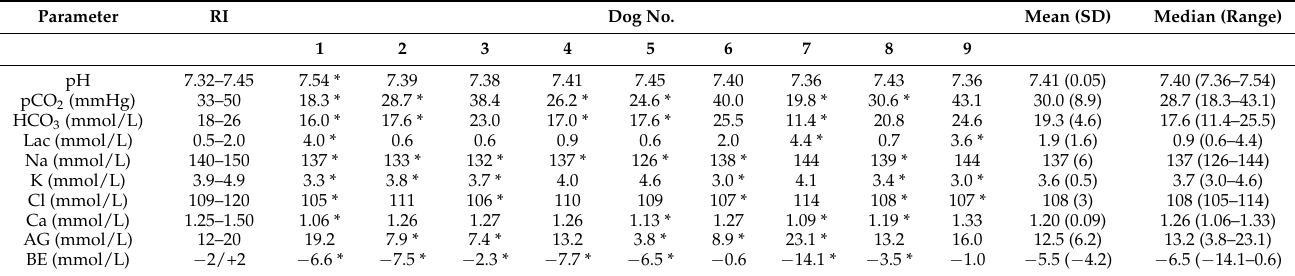
Table 3. Blood gas analyses results of 9 dogs with canine parvovirus enteritis. Parameter RI Dog No. Mean (SD) Median